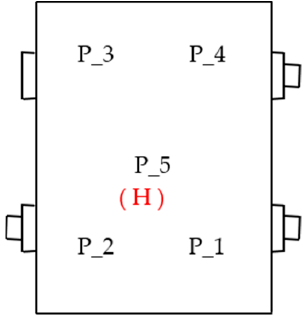
Figure 3. Arrangement of the measurement points of vibration (P) and noise (H).